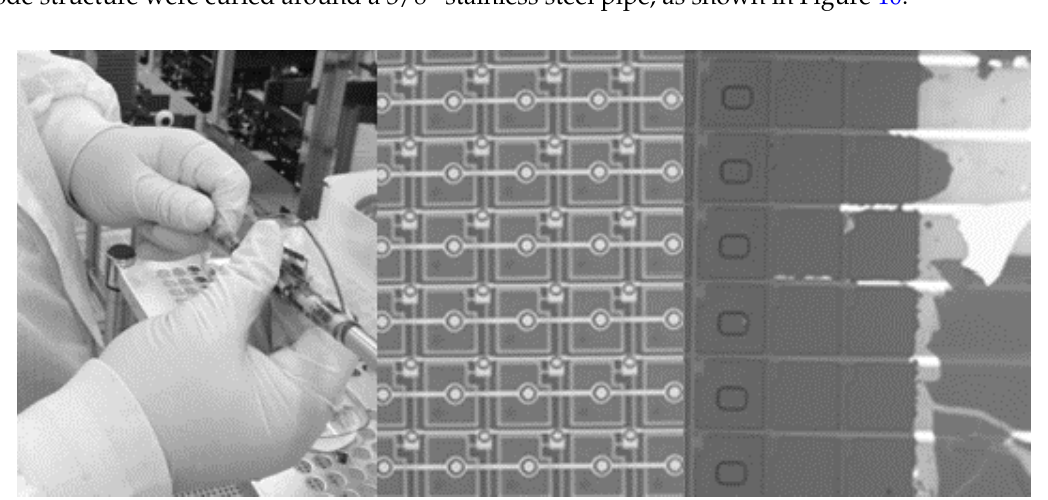
Figure 11. Curl comparison of low coefficient of thermal expansion (CTE) polyimide ( Left ), PEN ( Middle ), and high CTE polyimide ( Right ) debonded.